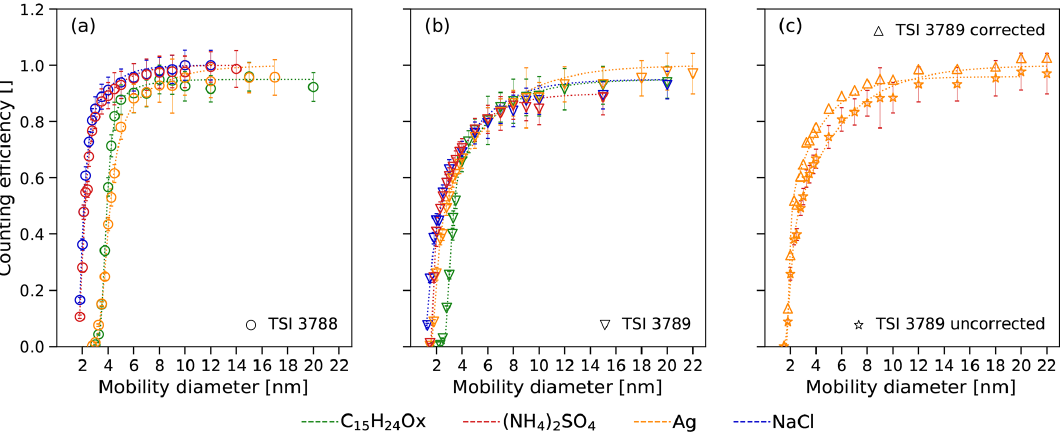
Figure 3. Detection efficiencies of the water-based CPCs: the figure shows the detection efficiencies as a function of the electrical mobility equivalent diameter. Panel (a) corresponds to the TSI 3788, and panel (b) shows the data measured with the TSI 3789. Panel (c) displays the data set for Ag that has been corrected for diffusion losses; panels (a, b) show uncorrected